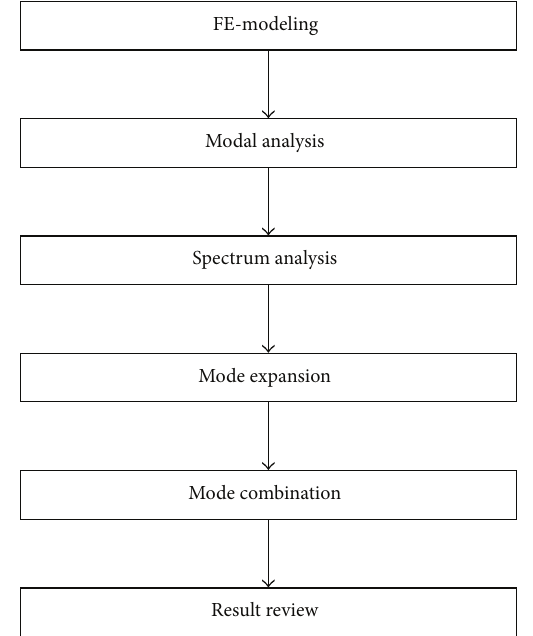
Figure 8: Flow chart for response spectrum analysis based on dynamic analysis.